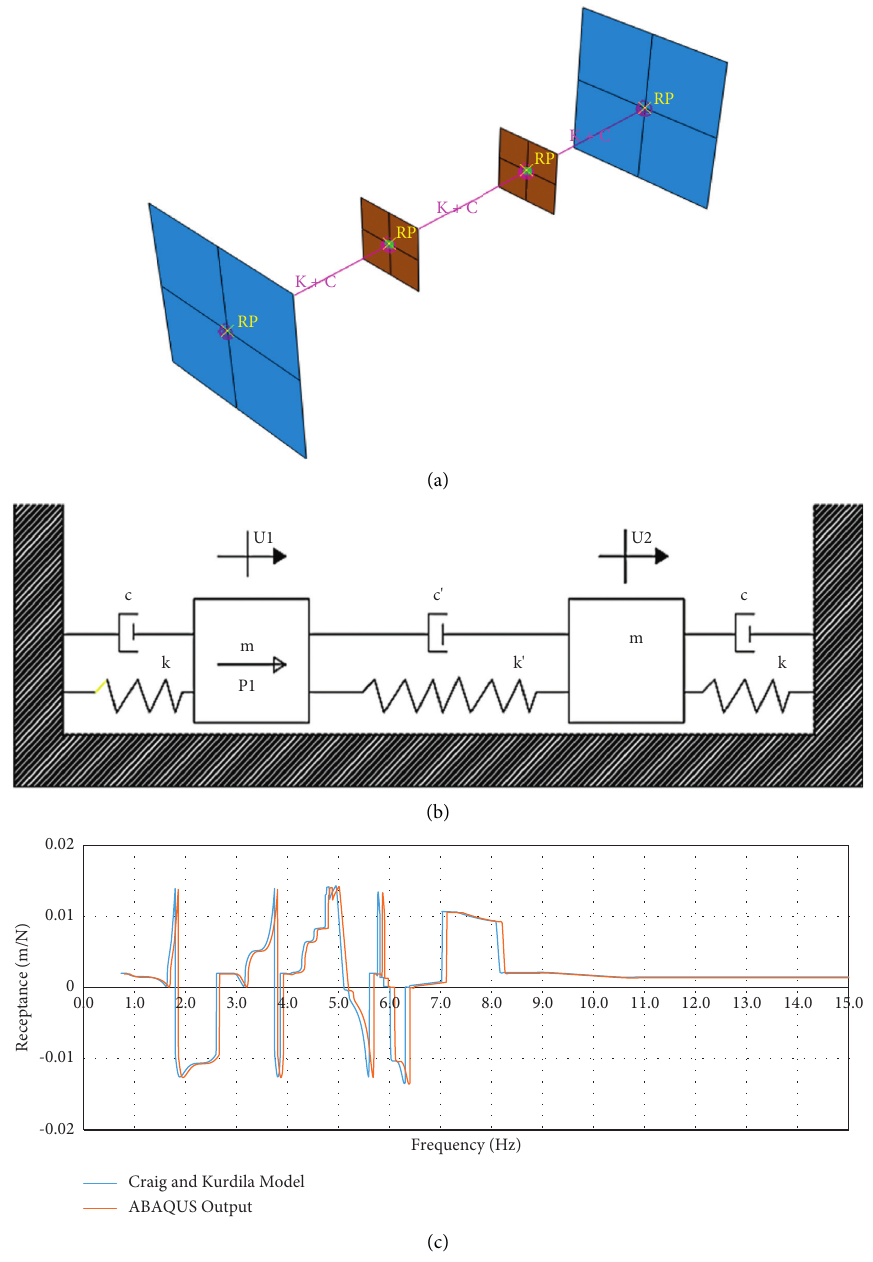
Figure 2: Modeling two-degree-of-freedom system of mass and spring and validation of frequency response based on the study of Craig and Kurdila [49]: (a) two-degree-of-freedom model in ABAQUS, (b) two-degree-of-freedom system of mass and spring with harmonic excitation in ABAQUS [49], and (c) validation of frequency response based on the study of ABAQUS output and Craig and Kurdila model